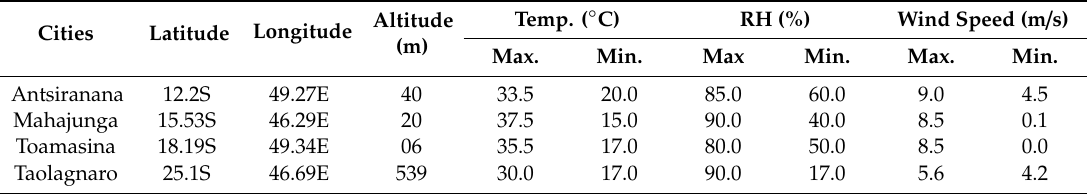
Table 1. Climatic characteristics of four cities.